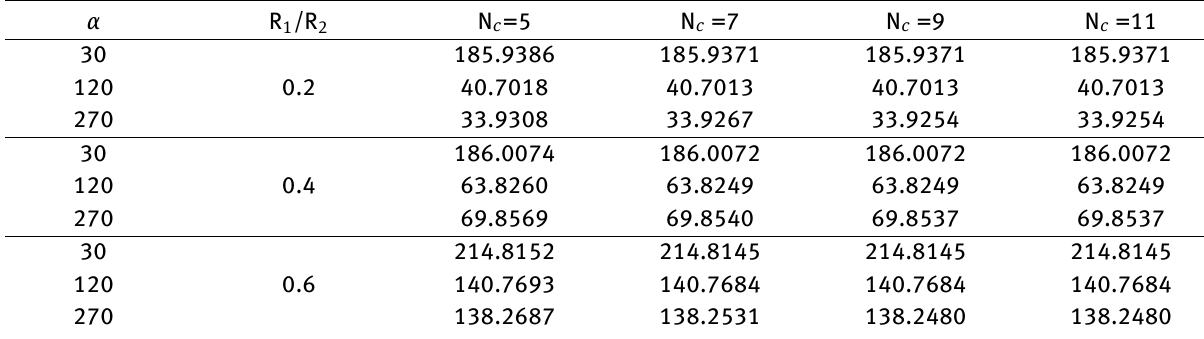
Table 4: Fundamental frequency ( Ω = ωR 2 2 √︀ ρh / D ) of the annular sector plates with CCCC edges (N r